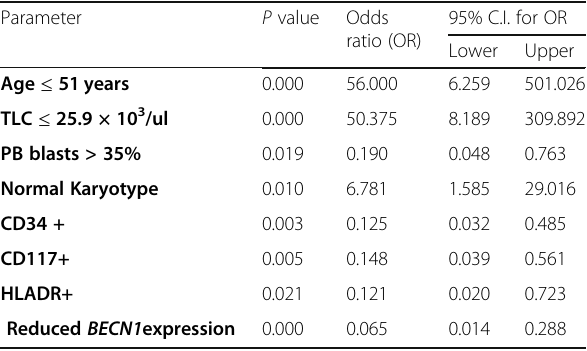
Table 5 Univariate logistic regression analysis for predictors of response to induction therapy